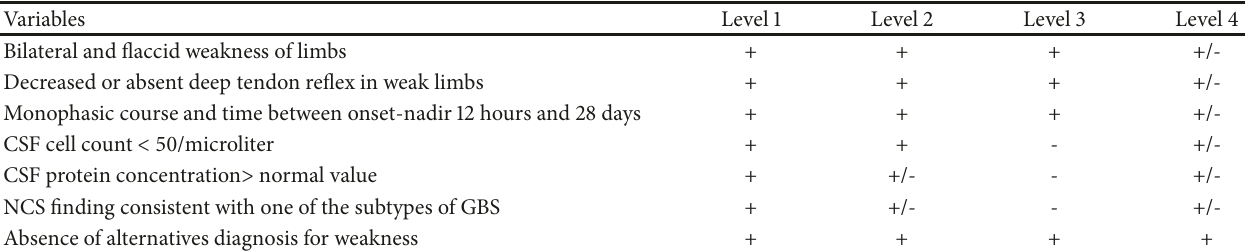
Table 1: Brighton criteria level of diagnostic certainty of Guillain-Barre syndrome.